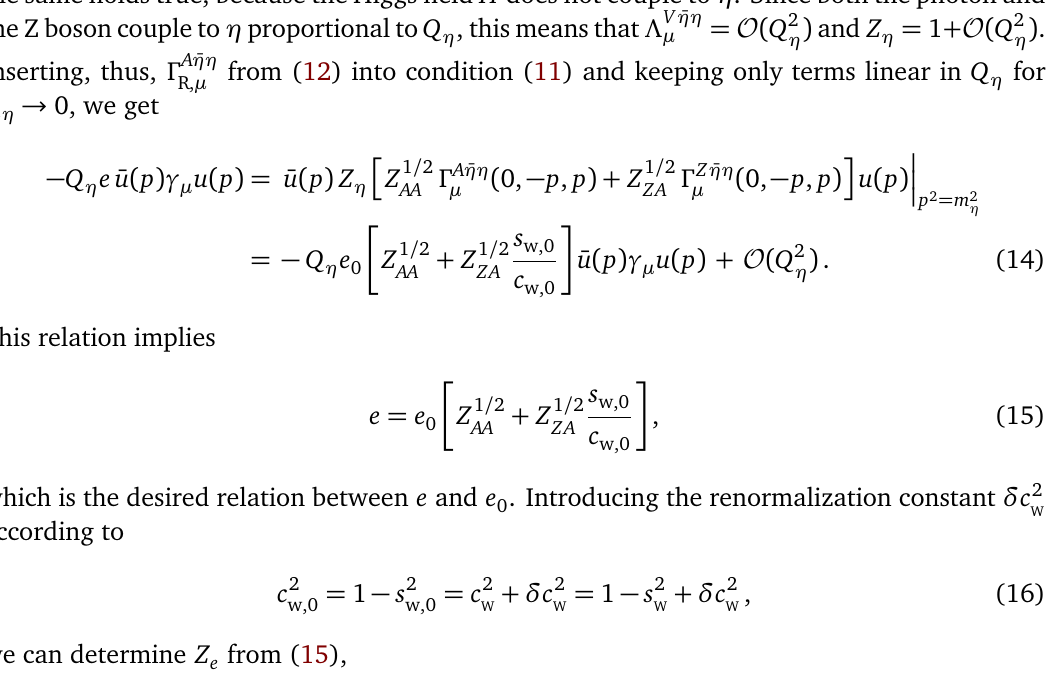
Figure 1: Some higher-order diagrams contributing to Γ V ¯ which receive contributions from 1PI diagrams (a, b, d, e), from explicit tadpole diagrams (c), and from diagrams involving tadpole counterterms δ t